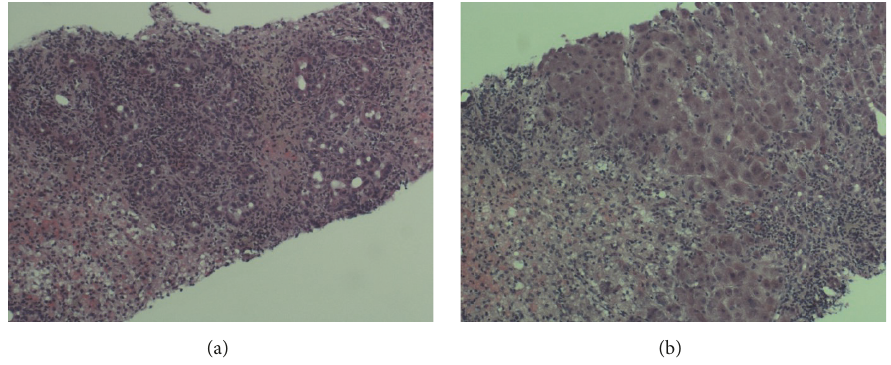
Figure 1: US-guided liver biopsy showing submassive